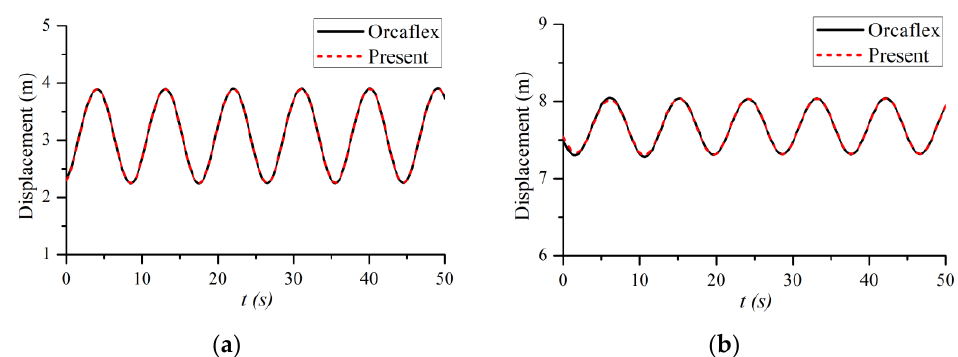
Figure 4. Comparison of the payload motion under the sinusoidal crane tip excitation ( H s = 0.3 m, T s = 9 s) with a payout speed of 0.2 m/s at different water depths: ( a ) 1500 m depth, ( b ) 3000 m depth.